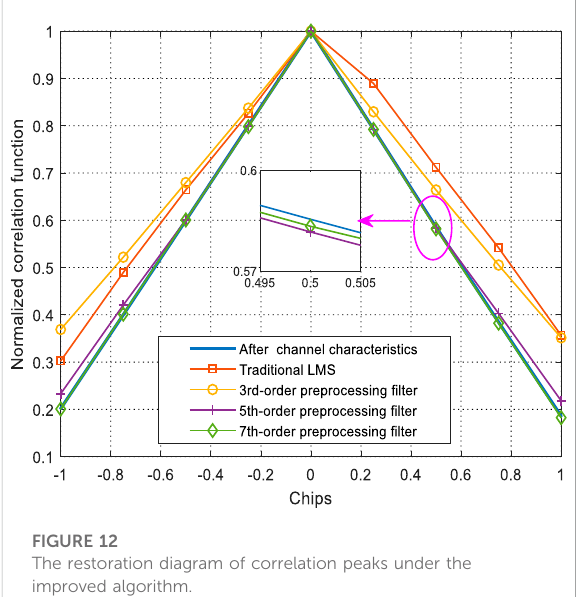
FIGURE 12 The restoration diagram of correlation peaks under the improved algorithm.